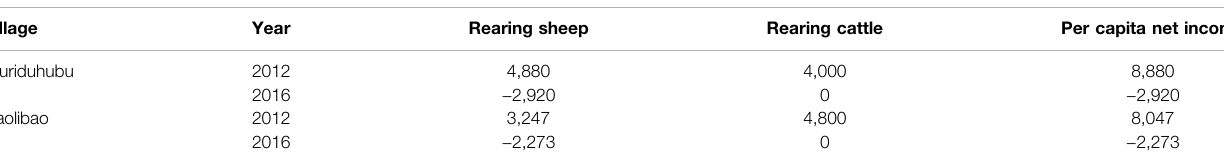
TABLE 5 | Livelihood incomes in herder villages.